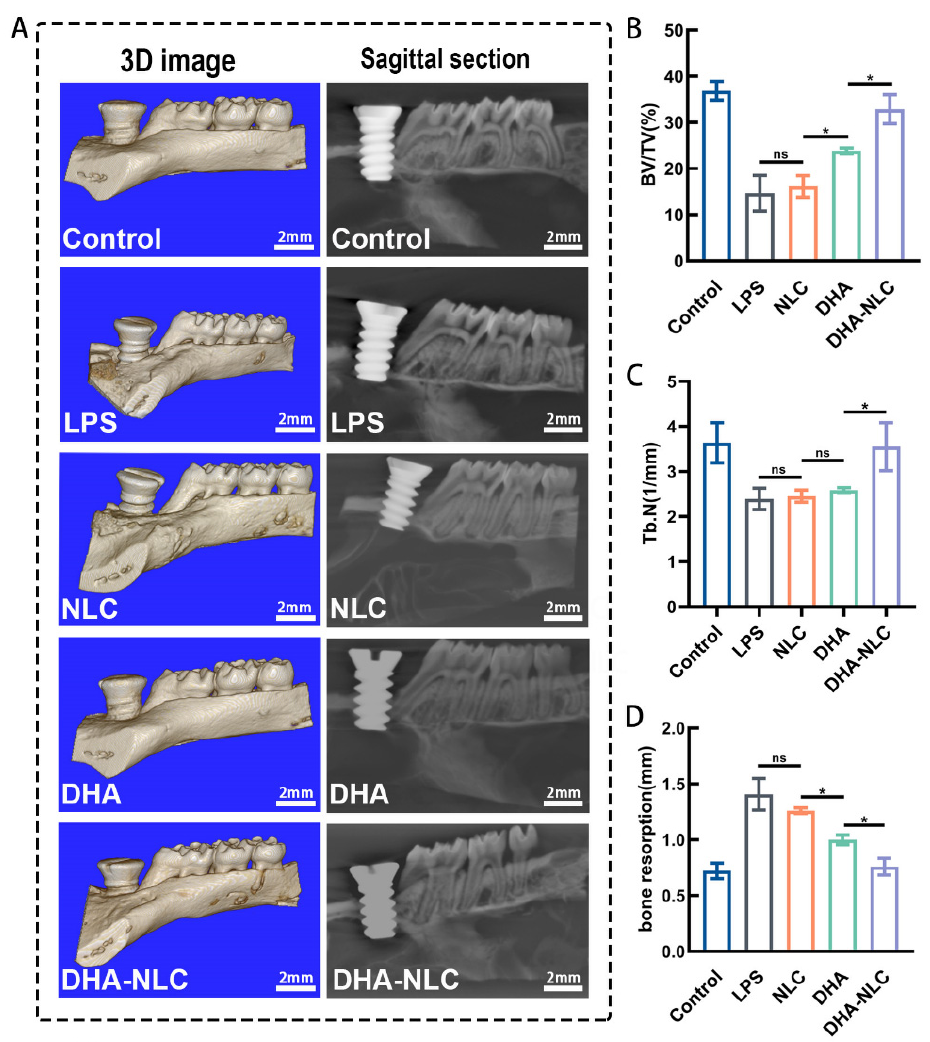
Figure 5. Effect of each group on bone resorption in the peri-implantitis model in vivo. ( A ) Micro-CT images of the rat alveolar bone. ( B , C ) Bone morphometric parameters: bone volume/tissue volume (BV/TV) and trabecular number (Tb.N) around the titanium implants (n = 3). ( D ) Bone resorption level (n = 3). Scale bars: 2 mm. * p < 0.05. LPS, lipopolysaccharide. NLC, nanostructured lipid carrier. DHA, docosahexaenoic acid.